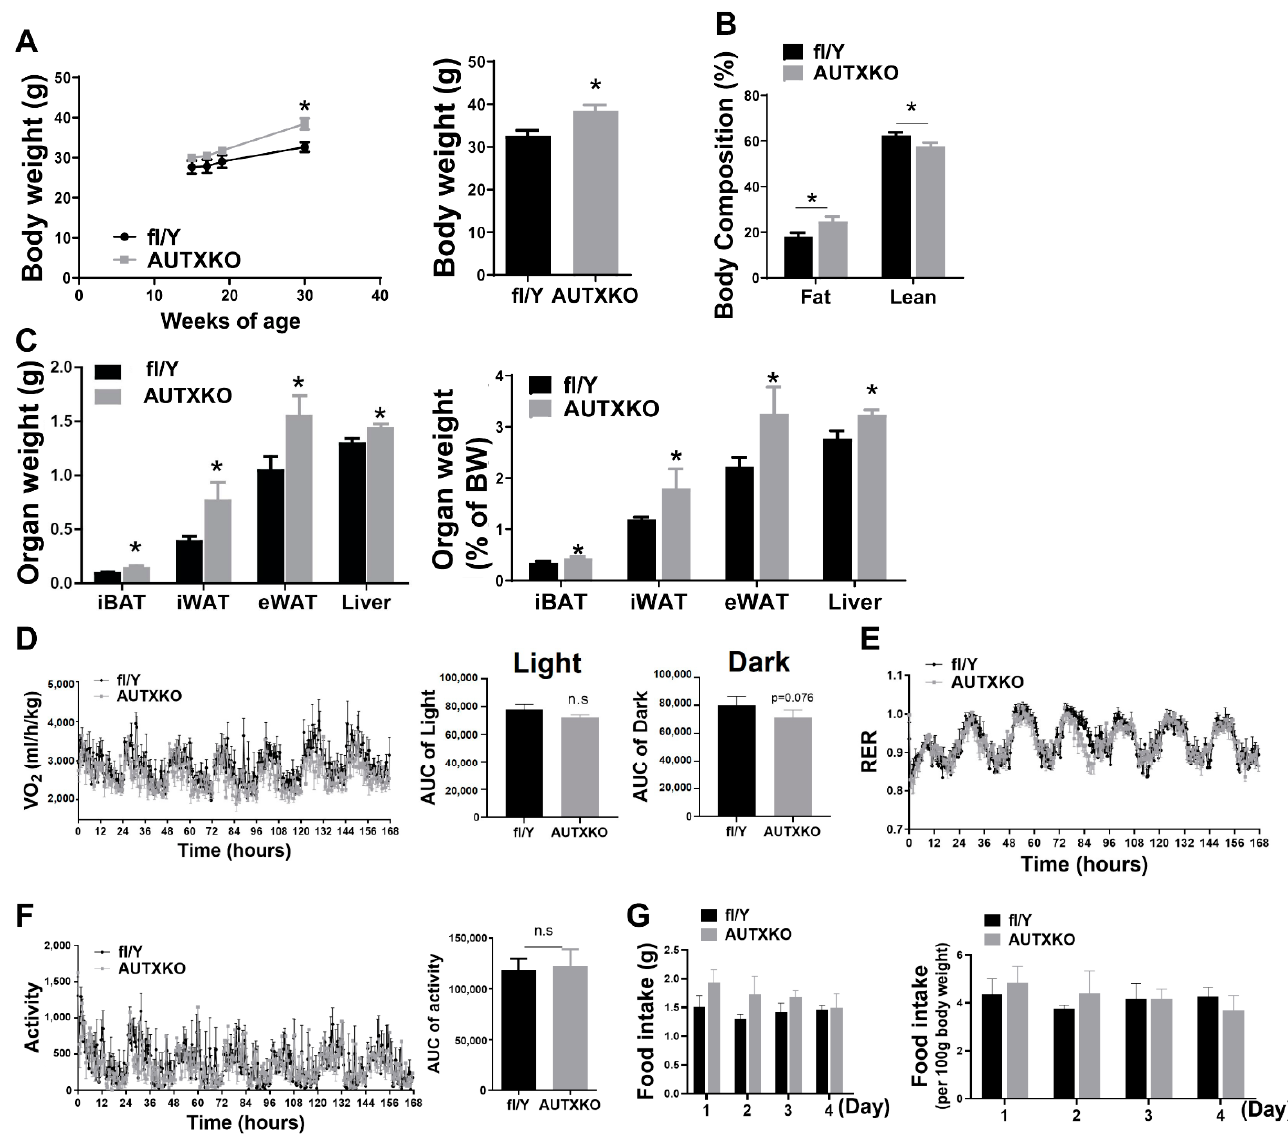
Figure 1. Utx deficiency in adipocytes reduces adiposity in mice fed a chow diet. Three-week-old male AUTXKO and their littermate fl/Y controls were maintained on a regular chow diet throughout the experiment. ( A – C ): ( A ) Body weight in male AUTXKO and fl/Y animals in a time course ( left ) and at the age of 30 weeks ( right ). ( B ) Fat and lean mass composition in male AUTXKO and fl/Y animals at the age of 30 weeks. ( C ) Absolute organ weight ( left ) and organ weight normalized to body weight ( right ) of iBAT, iWAT, eWAT and liver in male AUTXKO and fl/Y animals at the age of 36 weeks. ( D – G ): 33-week-old male AUTXKO and fl/Y animals maintained on a chow diet were put in TSE PhenoMaster metabolic cage system for metabolic characterization, including: ( D ) Oxygen consumption; ( E ) Respiratory exchange ratio (RER); ( F ) Locomotor activity; ( G ) Daily food consumption presented as food gram/mouse/day ( left ) and food gram/100 g body weight ( right ). All data are presented as mean ± S.E.M.; n = 4/group; * p < 0.05 vs. fl/Y